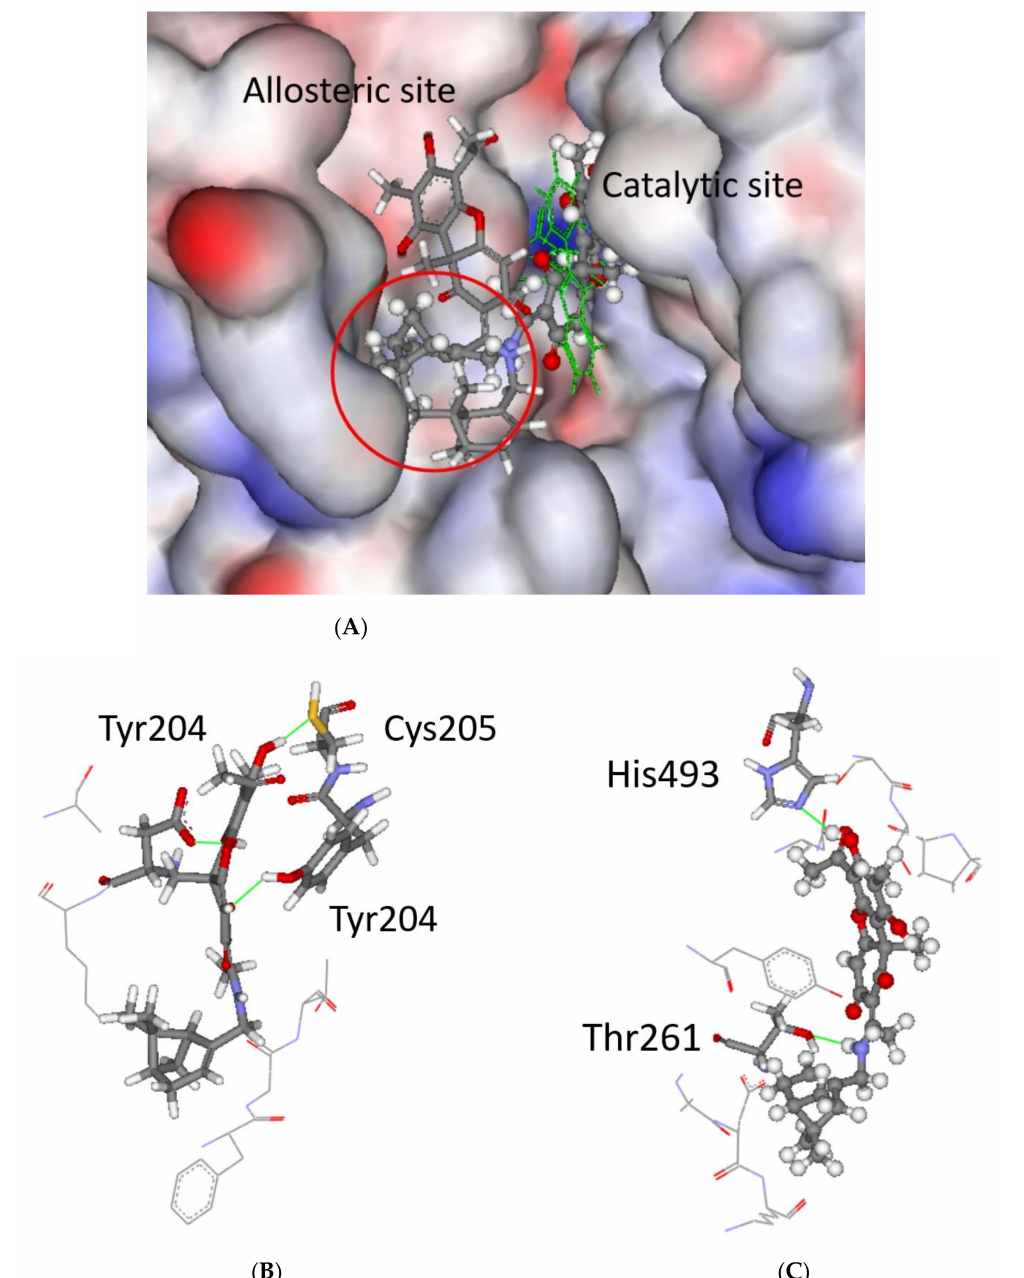
Figure 11. The docked poses of 11d in both potential binding sites of TDP1 as predicted by the ASP scoring function. ( A ) The allosteric site is to the left-hand side, and the ligand’s predicted conformation is shown in stick format. The catalytic pocket is to the right-hand side, and the ligand is depicted as balls and sticks, reaching into the allosteric pocket with its aliphatic bicyclic ring (see circled area). The co-crystalized ligand is shown (green lines) buried in the catalytic pocket. The protein surface is rendered; blue depicts regions with a partial positive charge on the surface, red depicts regions with a partial negative charge, and gray shows neutral areas. ( B ) Allosteric site: The predicted configuration is shown in the stick format as well as Tyr204, Cys205, and Asp230, which formed hydrogen bonds (green lines) to the ligand. Adjacent amino acid residues buttressing the ligand are shown in the line format (Lys231, Ala234, Phe259, Gly260, Thr261); the hydrogen atoms are not shown for clarity. ( C ) Catalytic pocket: The predicted configuration depicted as balls and sticks with hydrogen bonding amino acid residues Thr261 and His493. The adjacent amino acids are Tyr204, Gly229, Asp230, Lys231, Phe259, Gly260, Ser399, Ser400, Pro461, and